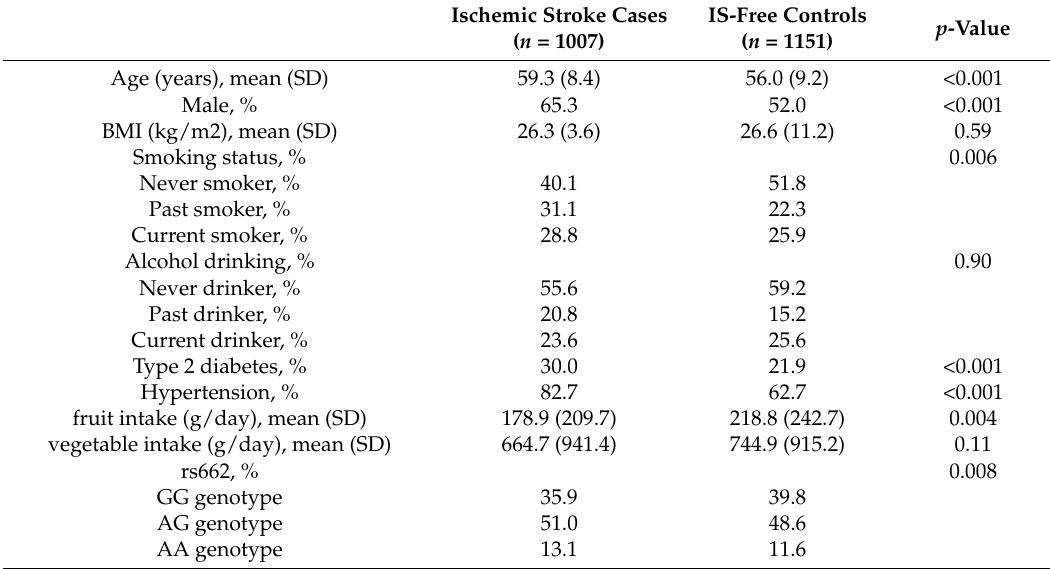
Table 1. Characteristics of participants according to ischemic stroke status.